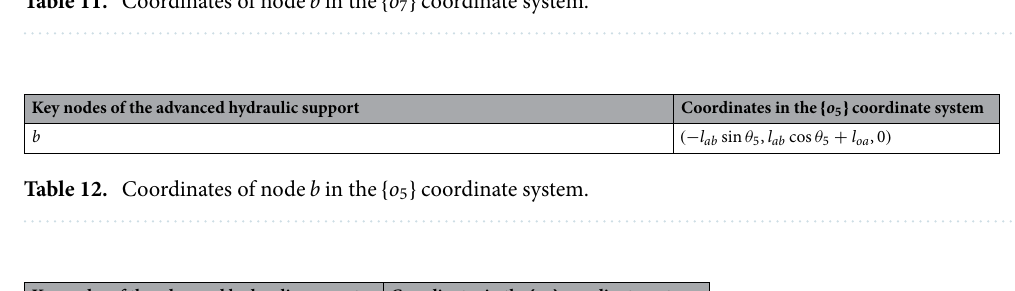
Table 11. Coordinates of node b in the { o 7 } coordinate system.